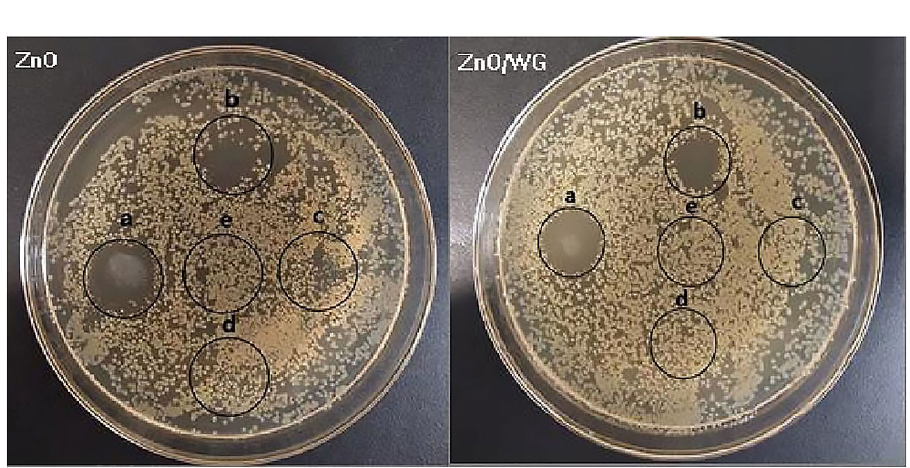
Table 1. The data concerned with specific surface area and pore size. WG concentrations while preparation: (a) 2 mg/mL; (b) 4 mg/mL; (c) 6 mg/mL; (d) 8 mg/mL; (e) 10 mg/mL.